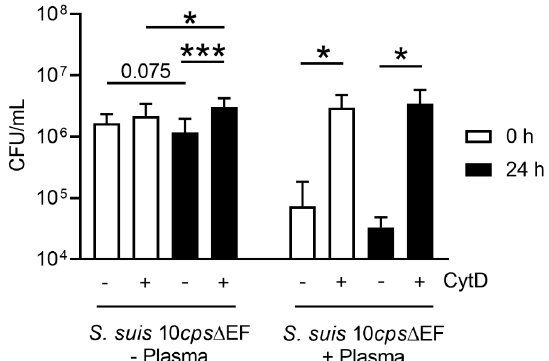
Figure 9. Neutrophils can phagocytize the bacteria independent of the storage. Slightly higher elimination of S. suis occurs with neutrophils from fresh blood when phagocytosis is inhibited. Slightly higher elimination of S. suis with neutrophils from stored blood occurs when phagocytosis is not inhibited. Data were analyzed with one-tailed paired Student’s t -test ( n = 8, no autologous plasma) ( n = 5, autologous plasma added) and presented with mean ± SD (* p < 0.05, *** p <